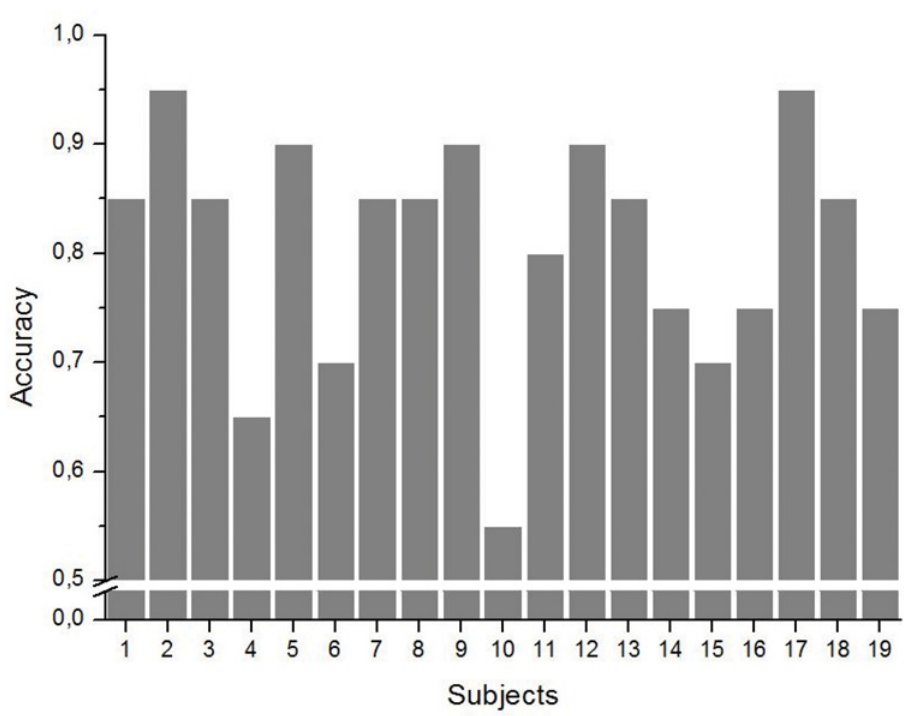
Fig 9. Machine learning result: WM Load level estimation accuracy for each